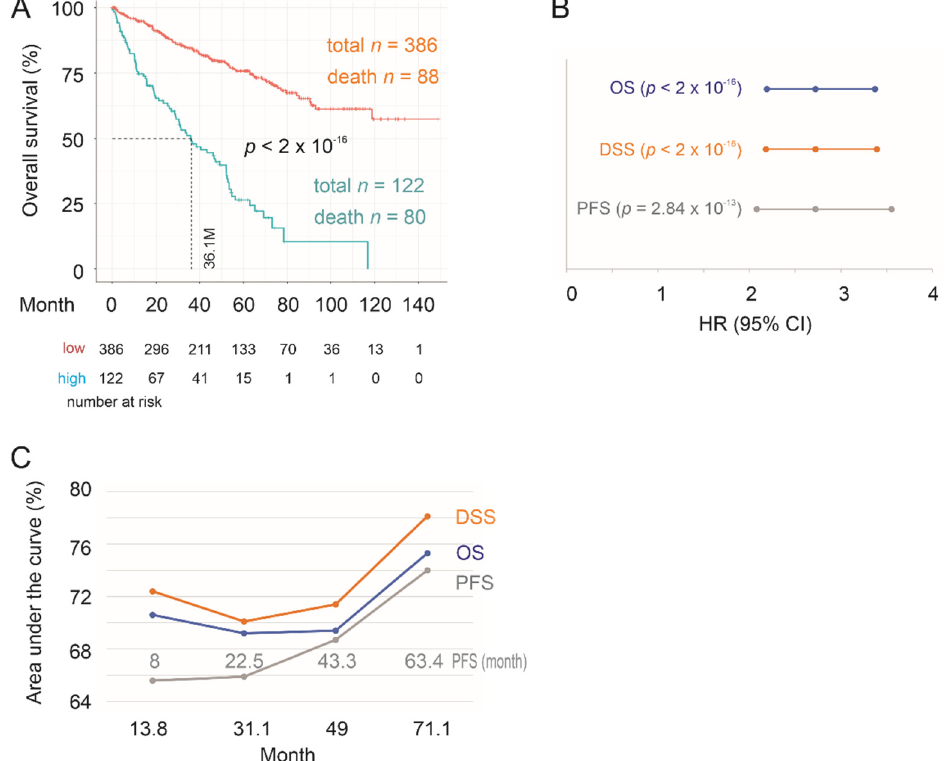
Figure 5. SigIQGAP1NW classifies the risks of poor prognosis of ccRCC in the TCGA PanCancer Atlas ccRCC cohort with a high degree of certainty. ( A ) Kaplan Meier survival curve. ( B ) HR, 95% CI, and p values for the indicated ccRCC events. ( C ) Time-dependent ROC curve. Months for PFS are specifically labeled.